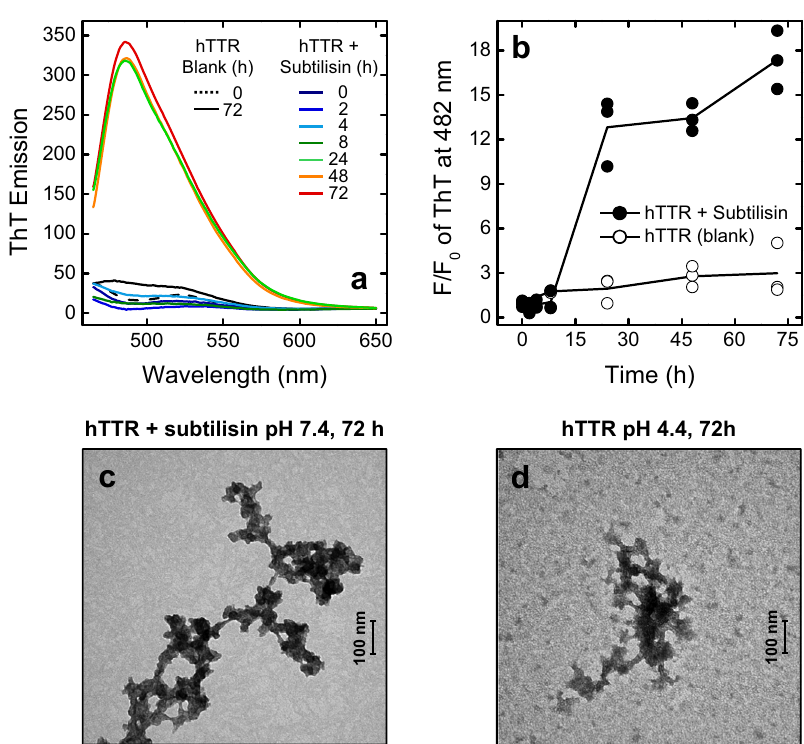
Fig. 5 hTTR amyloid fi bril formation during proteolysis with subtilisin. hTTR (1 mg/ml) was treated at 37 °C with subtilisin in TBS buffer, pH 7.4, 5 mM CaCl 2 at an enzyme:hTTR ratio of 1:20 (mol/mol). At time points, aliquots (50 µ l) of the proteolysis reaction were withdrawn, diluted ten-fold with the same buffer, and analysed by ThT binding assay and TEM. a Fluorescence emission spectra of ThT during proteolysis of hTTR (1 mg/ml) with subtilisin. At the indicated time points, aliquots of the proteolysis mixture were added with ThT (20 µ M) and samples were excited at 450 nm and 25 ± 0.1 °C. b Time- course fl uorescence intensity of ThT at 482 nm during subtilisin-induced proteolytis of hTTR (black circles). The data points result from three different experiments. The time-course emission of ThT, in the presence of intact hTTR alone (without subtilisin), is reported as a control (white circles). The fl uorescence signal is expressed as F / F F = 0 min. c Representative TEM micrograph of hTTR fi brils, 0 , where 0 is the emission intensity of ThT at time generated after 72-h incubation of hTTR (0.2 mg/ml) with subtilisin at 37 °C in 20 mM potassium phosphate, pH 7.6, 100 mM KCl. d For comparison, a representative micrograph of hTTR fi brils, generated after incubation of intact hTTR (0.2 mg/ml) under acidic conditions (0.2 M potassium acetate buffer, pH 4.4) for 72 h at 37 °C is also shown. The scale bar (100 nm) is